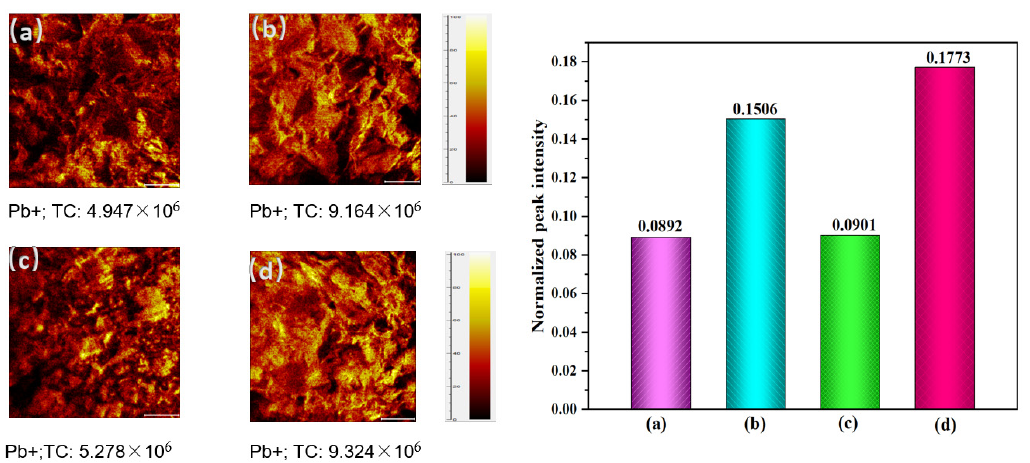
Figure 3. ToF-SIMS results of the 2D distribution of ions on cerussite surfaces and normalized peak intensities of sample ions treated with different conditions: ( a ) cerussite, ( b ) cerussite + Pb 2+ , ( c ) cerussite + Na 2 S, and ( d ) cerussite + Pb 2+ + Na 2 S.